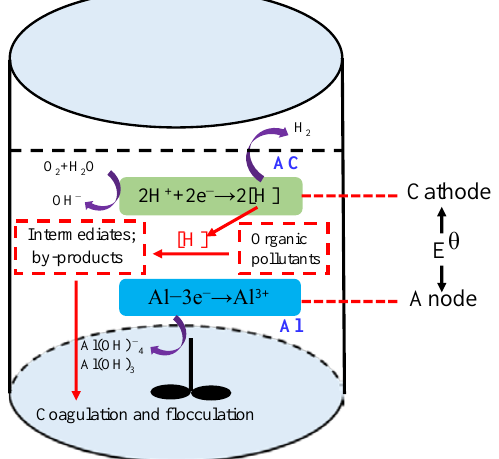
Table 2. Analysis of variance q.